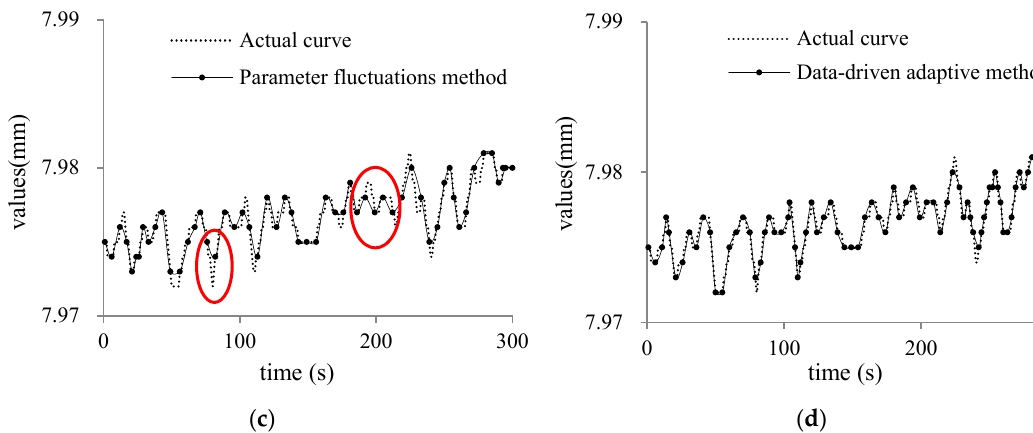
Figure 8. ( a ) constant sampling curve of displacement; ( b ) spectrum-based curve of displacement; ( c ) parameter fluctuations curve of displacement; ( d ) data-driven adaptive curve of displacement.